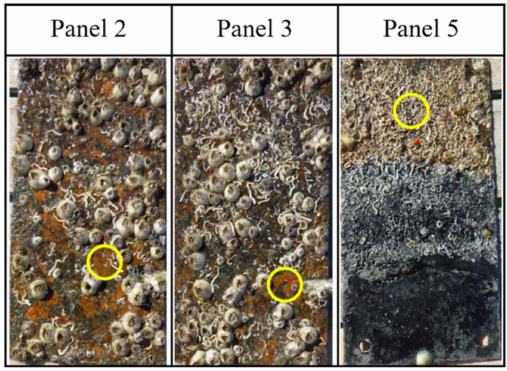
Figure 11. Areas analyzed with EDX.